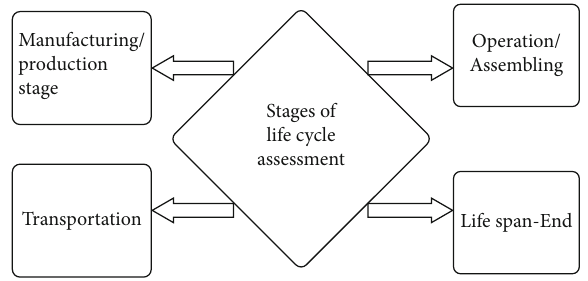
Figure 1: Stages of life cycle